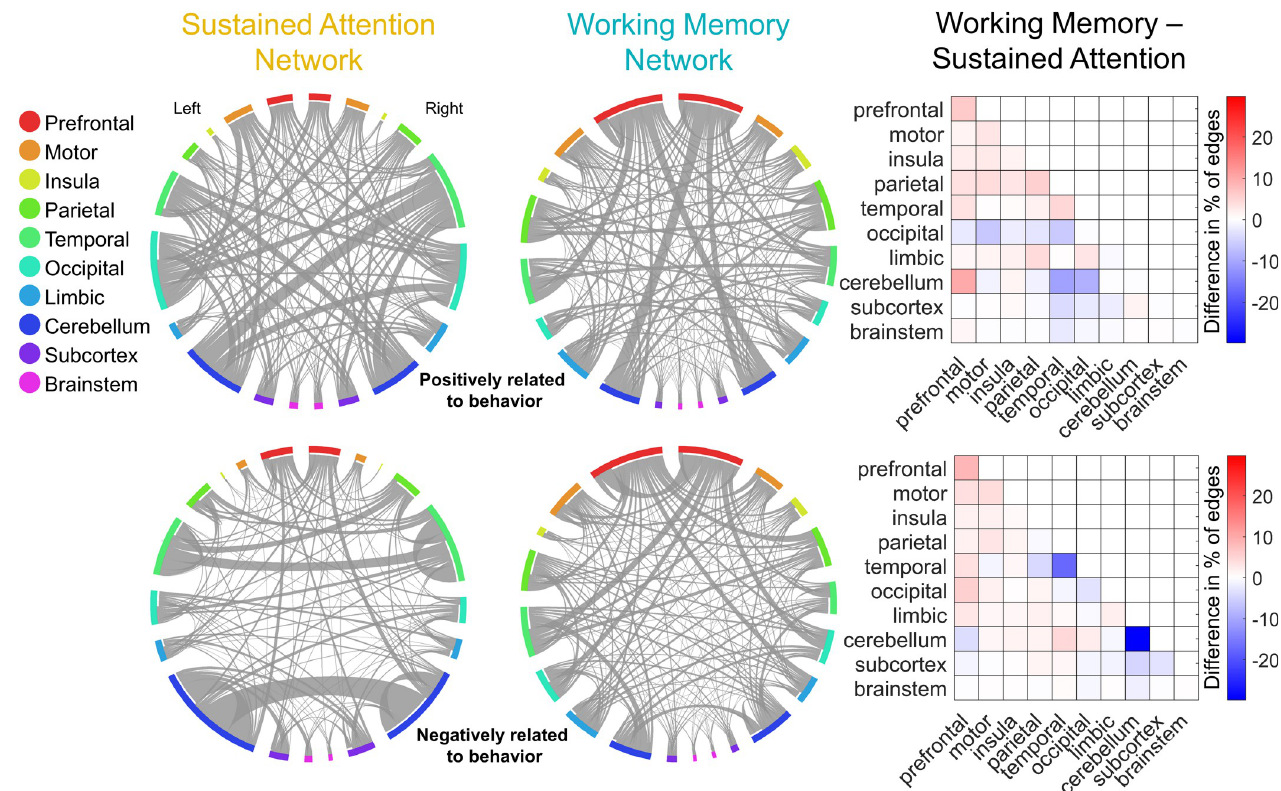
Fig 2. Adult SA and WM networks and their differences. The circle plots (connectograms) show the SA and WM networks on the Shen-268 parcels grouped into 20 anatomical regions (10 per hemisphere). The networks positively related to the behavior are shown on the top row and the networks negatively related to the behavior are shown in the bottom row. The matrix plots show the percentage of edges belonging to each macroscale region in WM connectogram minus the percentage of edges belonging to each macroscale region in SA connectogram. Differences in networks predicting better attention and working memory are shown in the top matrix plot; differences in networks predicting worse attention and working memory are shown in the bottom matrix plot. The data for this figure are available at NDA study 1849 10.15154/1528288. Circular plots are made with Circos [28]. SA, sustained attention; WM, working memory.